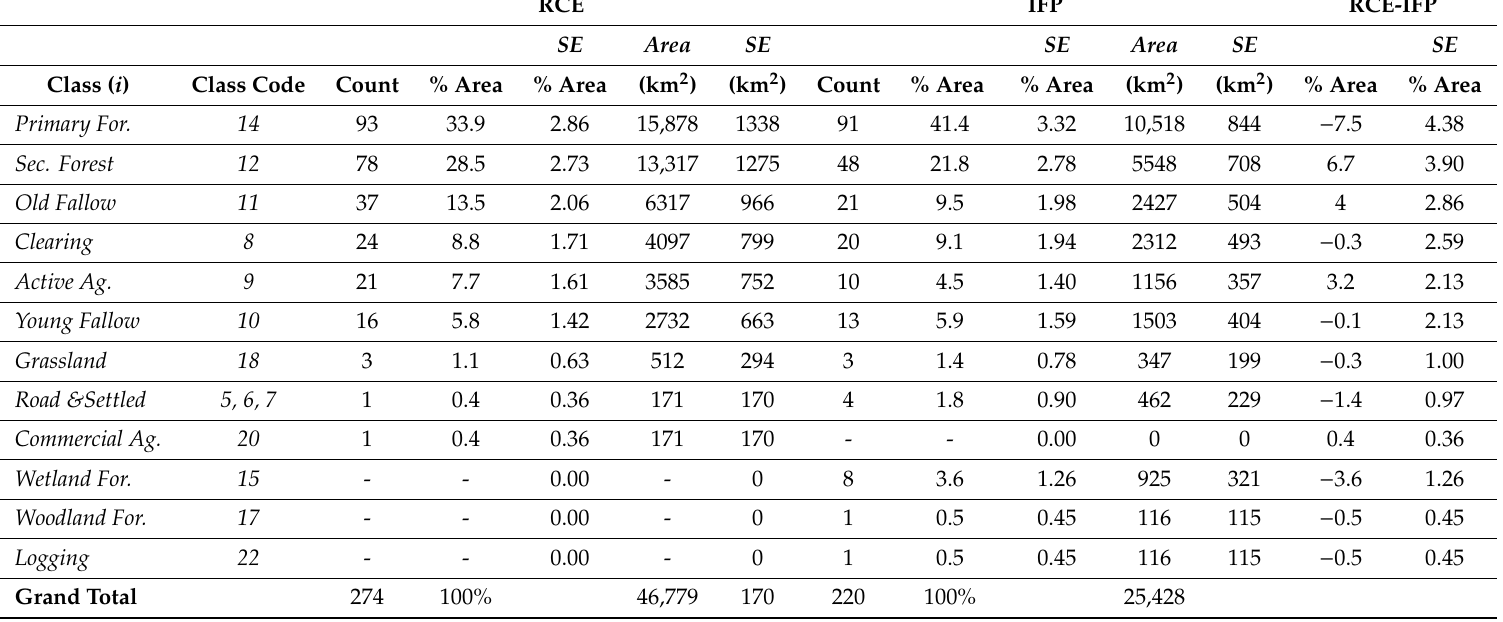
Table 2. Estimated area percent area of land cover classes in the RCE and